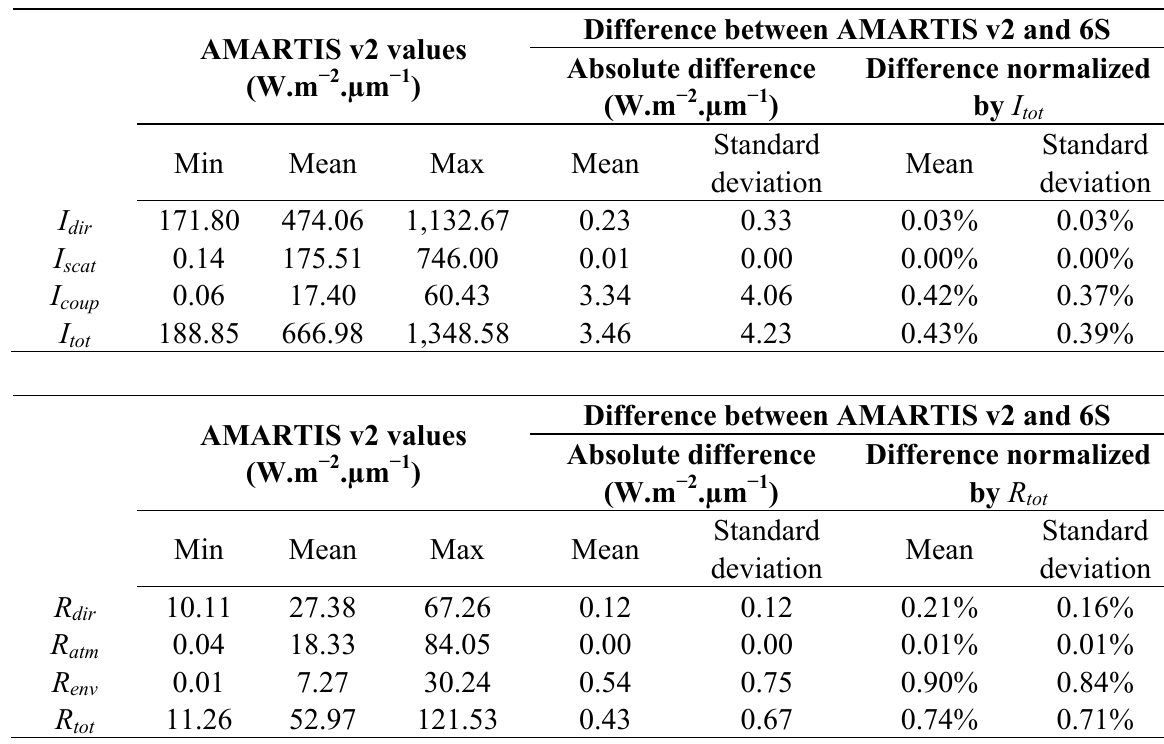
Table 3. Comparison of the results obtained between AMARTIS v2 and 6S on the 27 simulation